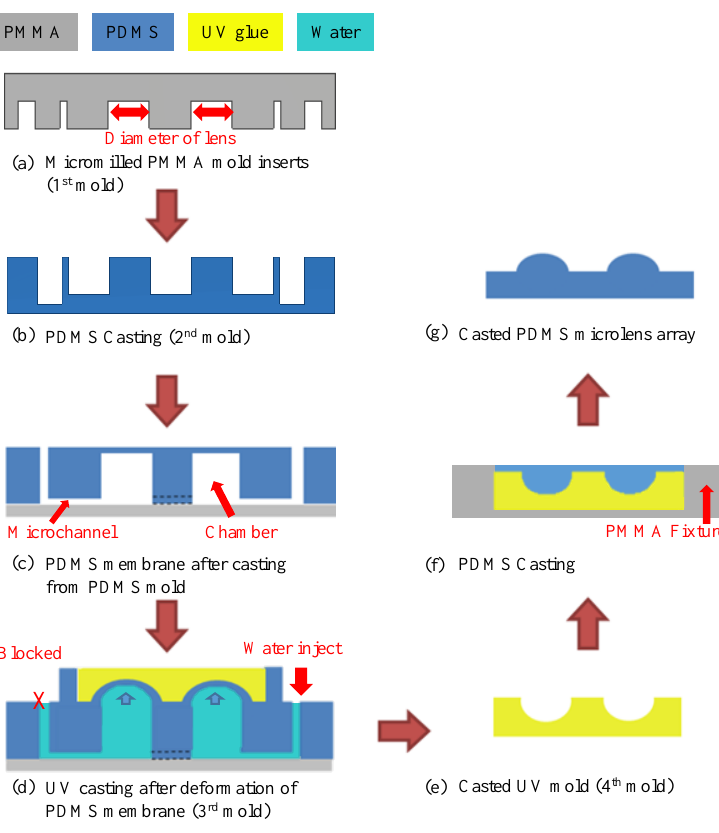
Figure 3. Overall revised fabrication process: ( a ) micromilling of mold; ( b ) casting of polydimethylsiloxane (PDMS) mold from micromilled mold; ( c ) casting of PDMS membrane from assembled mold, the assembled mold is described in Section 2.3.3, then using partial-curing PDMS bonding to form hybrid microfluidic chip for fabrication of MLAs; ( d ) after water was injected